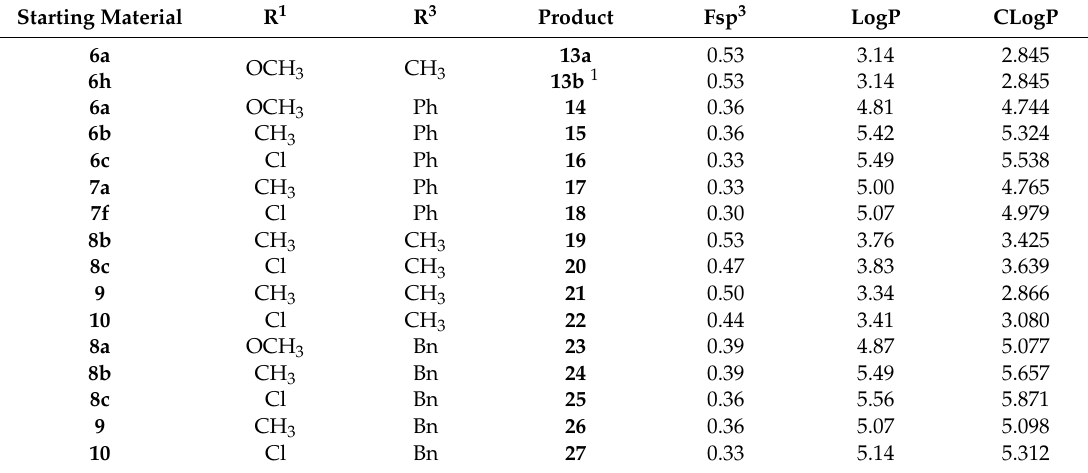
Table 3. Fsp 3 values of substituted